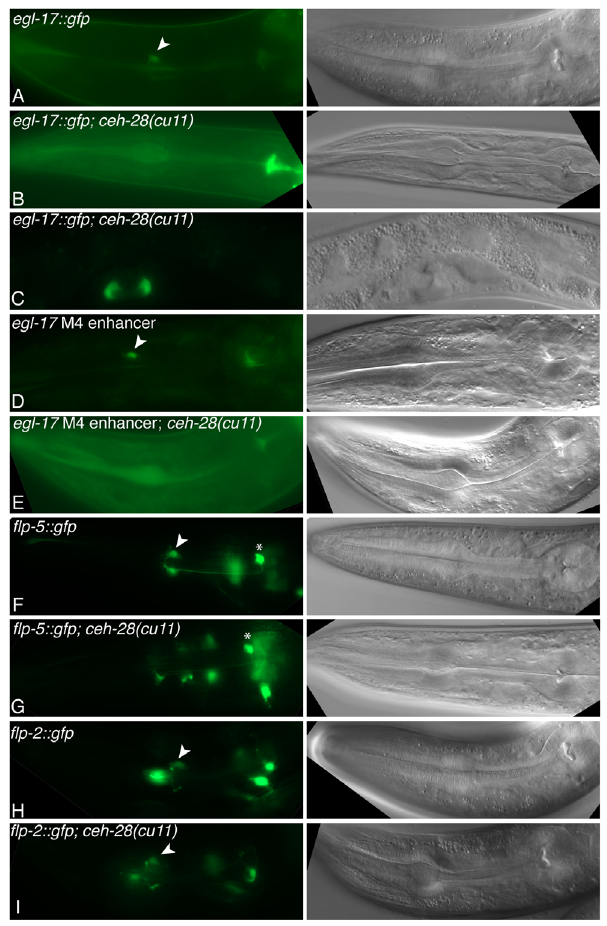
Figure 2. Expression of M4 differentiation markers in ceh-28(cu11) mutants. Fluorescence (left) and DIC (right) micrographs of L4 to adult animals of the indicated genotypes bearing egl-17::gfp ayIs4 (A–C), the egl- 17 M4 enhancer:: D pes-10::gfp cuEx793 (D,E), the flp-5::gfp ynIs49 (F,G), or the flp-2::gfp ynIs57 (H,I). (A,B,D–I) Expression in the pharynx with M4 (arrowhead) or I4 (asterisk, F and G) indicated. (C) egl-17::gfp expression in the vulva, which is unaffected in ceh-28 mutants.